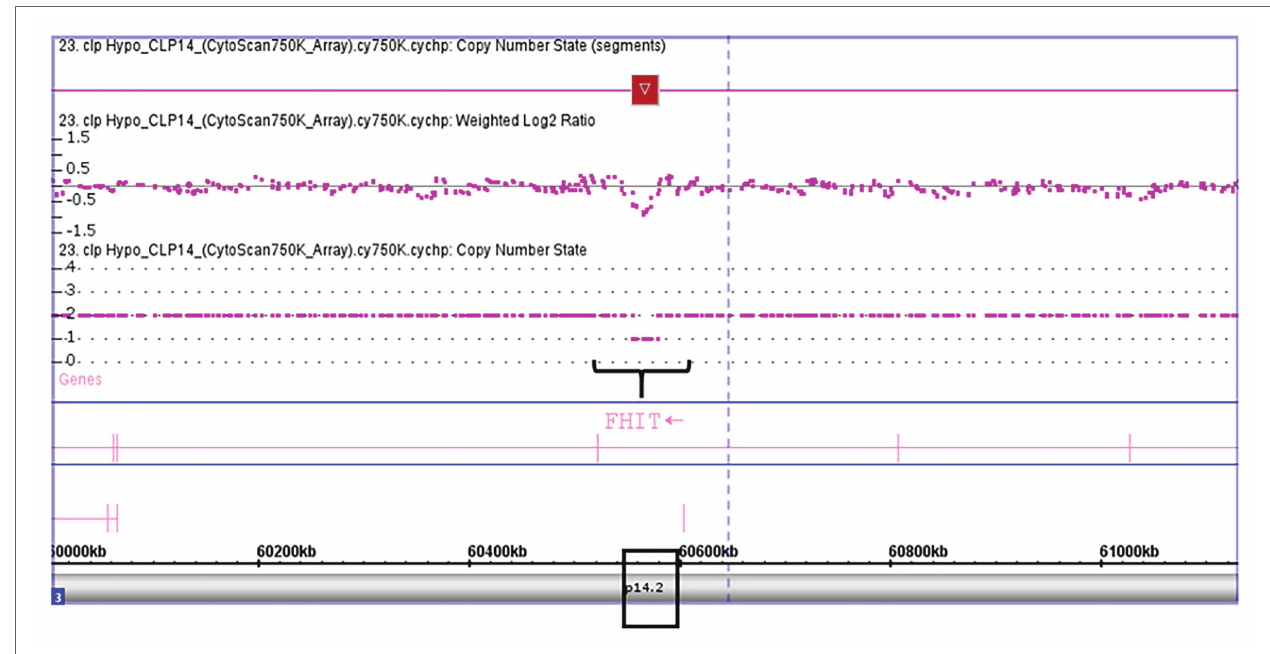
FIGURE 2 | Microarray-based copy number analysis performed with the Affymetrix CytoScan 750K array and visualized using the Affymetrix Chromosome Analysis Suite version 1.2.2. Image of the 26 kb loss at 3p14.2 (Chromosome 3:60,555,048-60,579,400; GRCH37/hg19) present in a girl 9 year-old. The region overlaps with FHIT gene (black box).